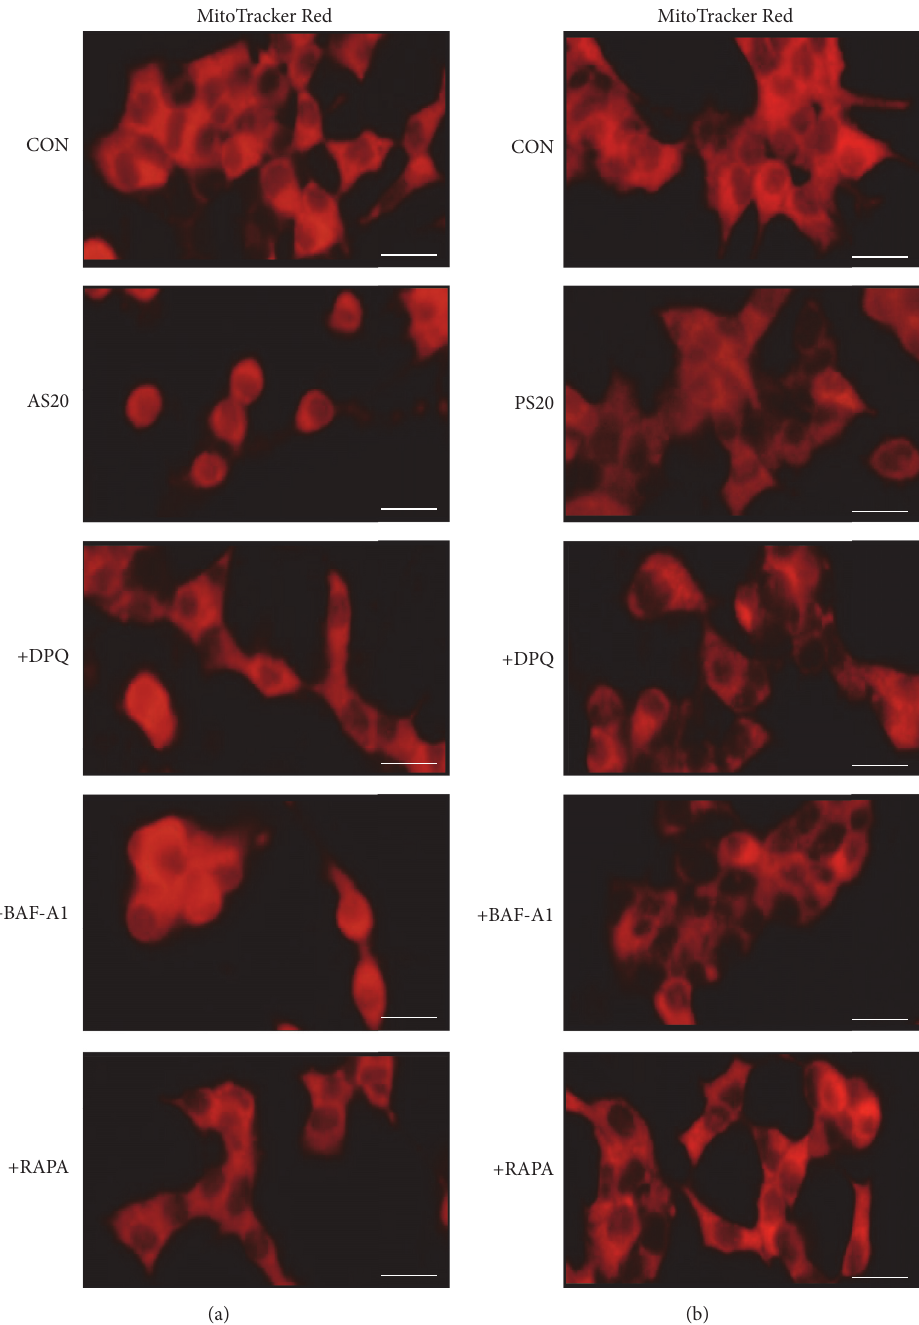
Figure 7: Confocal microscopic studies on AS-induced mitochondrial morphologic changes in NIT-1 cells. Cells were exposed to 20 𝜇 M AS or 20 𝜇 M PS with or without DPQ, BAF-A1, and RAPA pretreatment and stained with MitoTracker Red. After 48h of AS treatment (a), the cells exhibited substantially lessred fluorescent staining and mitochondria than thecontrol (decreased 0.6-fold) and contained round, discrete mitochondria and diffused weak cytoplasmic fluorescence, which increased red fluorescence and improved mitochondrial morphology after DPQ treatment. PS-treated cells (b) exhibited mildly decreased red fluorescence and mitochondria compared with the control (decreased 0.1-fold) and showed improved diffused weak cytoplasmic fluorescence after DPQ treatment. Magnification: × 40. Scale bar: 20 𝜇